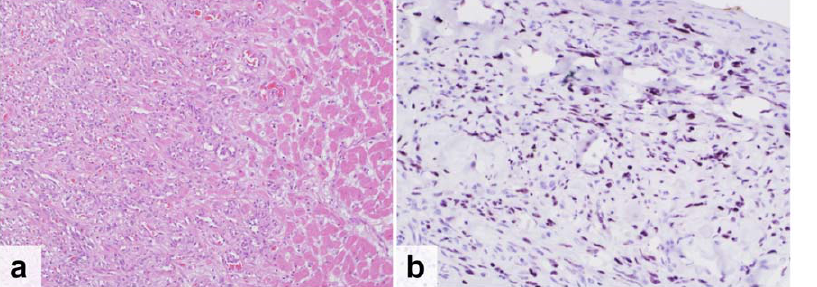
Figure 3. Kaposi’s Sarcoma. Disseminated Kaposi’s Sarcoma (KS) in a patient who was on lamivudine, zidovudine and nevirapine for 8 months and was treated for KS for 3 months. a. Note vascular proliferation of KS invading cardiac muscle (H&E) b. Kaposi’s associated Herpes virus detected in the pericardium (immunophenotyping using LANA1).